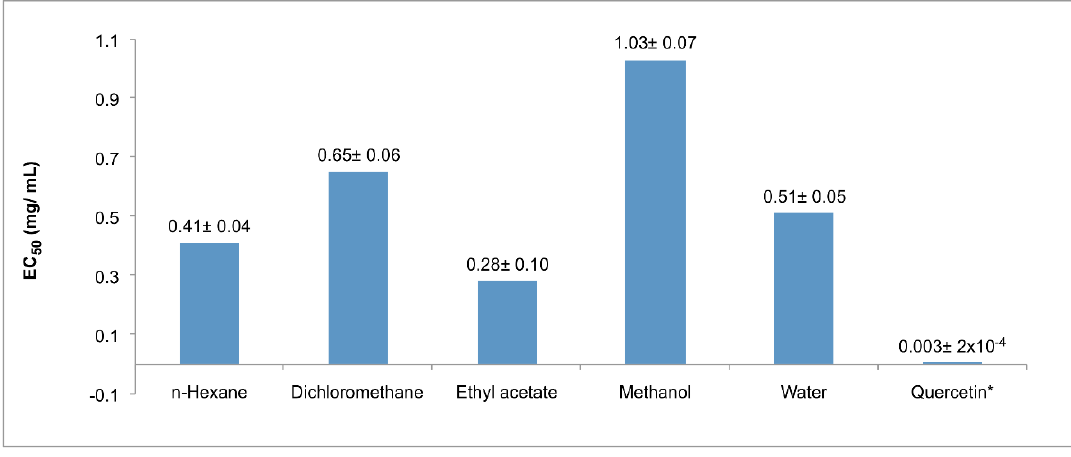
Figure 2. DPPH radical-scavenging capacity assay of extracts from aerial parts of S. pachyphylla . * Used as a reference compound. Values are mean ± SD, n = 3.